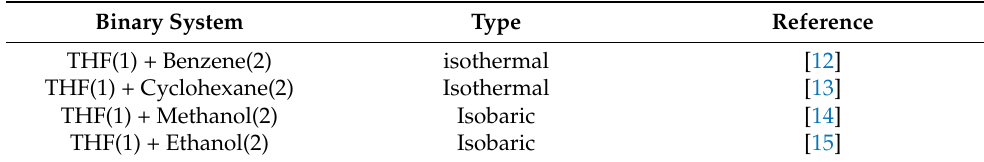
Table 1. Binary Vapor-Liquid Equilibrium